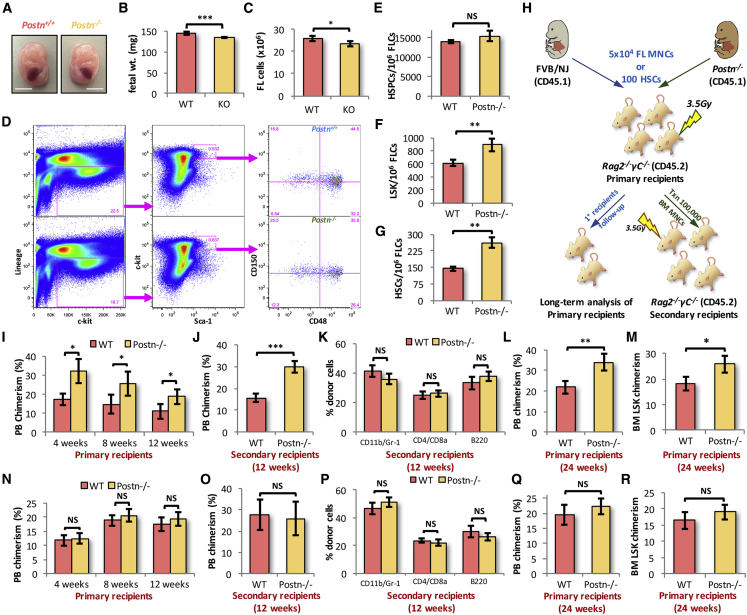
POSTN Deficiency Leads to Expansion of Functional HSCs in FL Tissue(A) Postn+/+ (WT) and Postn−/− (KO) embryos were harvested at E14.5, cleared of the extra-embryonic layers and gross morphology was compared. Scale bars, 5 mm.(B) Individual embryos were weighed and overall weight of the WT and KO embryos was compared.(C) Mononuclear cells from the E14.5 FL tissues were harvested and counted for the WT and KO embryos.(D–G) The mononuclear cells harvested from the FL tissue of WT and KO embryos were analyzed for the frequency of HSC sub-populations (D) by flow cytometry. The frequency of lin−c-kit+ cells (E), LSK cells (F), and primitive HSCs (G) in E14.5 FL mononuclear cells was compared between WT and Postn−/− embryos. n = 6–13.(H) Schematic representation of the competitive repopulation assays. A total of 50,000 total E14.5 FL cells or 100 E14.5 FL-derived FACS-sorted SLAM LSK cells from Postn+/+ (WT) or Postn−/− embryos (CD45.1) was transplanted into sub-lethally irradiated Rag2−/−γC−/− mice (CD45.2). PB chimerism was followed for 12 weeks, after which secondary transplantations were performed using BM cells from half of the primary recipients. The secondary recipients were analyzed for PB chimerism after 12 weeks of transplantation. The PB chimerism in the rest of the primary recipients was analyzed for up to 24 weeks of transplantation. Donor-derived chimerism in BM LSK population was analyzed in moribund mice. n = 3, N = 15–18.(I) Donor-derived PB chimerism in primary recipients analyzed after 4, 8, and 12 weeks of transplantation.(J) After 12 weeks of transplantation of BM cells from primary recipients, secondary recipients were analyzed for PB chimerism.(K) Multi-lineage engraftment in secondary recipients after 12 weeks of transplantation.(L) After 24 weeks of transplantation, donor-derived PB chimerism in primary recipients that received whole FL cells from WT or KO embryos.(M) The primary recipients analyzed after 24 weeks of transplantation for donor-derived chimerism in BM LSK population. Proportion of BM-derived cells in the total BM LSK cells was compared between the primary recipients that received whole FL cells from E14.5 WT or KO embryos (n = 3, N = 9–12).(N) PB chimerism in primary recipients transplanted with 100 SLAM LSK cells from the E14.5 FL tissues.(O) Secondary recipients analyzed for donor-derived PB chimerism 12 weeks after transplantation.(P) Donor-derived multi-lineage engraftment in secondary recipients 12 weeks after transplantation.(Q) Sorted HSCs from E14.5 WT or KO embryos were transplanted in sub-lethally irradiated animals. After 24 weeks of transplantation, donor-derived PB chimerism in primary recipients was compared between the two groups (n = 3, N = 7–11).(R) The primary recipients analyzed after 24 weeks of transplantation for donor-derived chimerism in BM LSK population. Proportion of BM-derived cells in the total BM LSK cells was compared between the primary recipients that received freshly sorted HSCs from E14.5 WT or KO embryos (n = 3, N = 9–12).An unpaired two-tailed Student's t test was performed. n = 3, N = 15–18, t test: ∗p < 0.03, ∗∗p ≤ 0.01, ∗∗∗p ≤ 0.005, NS indicates not significant. See also Figure S4.